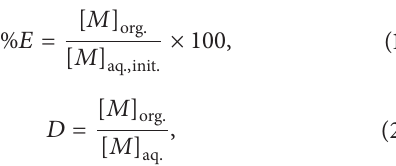
Figure 1: Plot of pH versus percentage extraction of platinum(IV) (150 𝜇 g/mL) from ascorbic acid medium (0.01M) by using n- octylaniline (0.1M) as an extractant in toluene with 3 min shaking time.